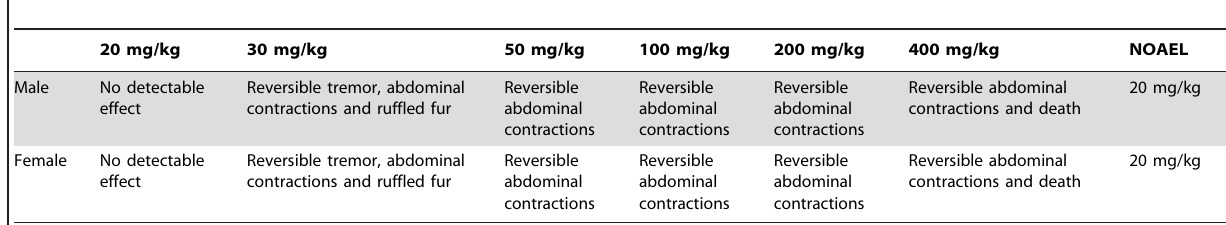
Table 2. Acute toxicity analysis – Escalating doses using a single mice (starting at 20 mg/kg up to 400 mg/kg DB1965 – ip –